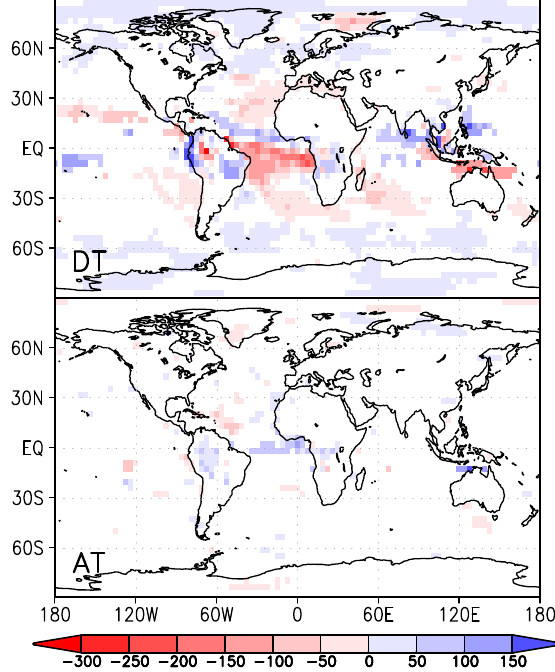
Fig. 10. Changes in annual mean moisture convergence in mm/yr, averaged over the years 11–300 for tropical deforestation (top) and tropical afforestation (bottom). White areas show no significant changes according to a t-test with 95%